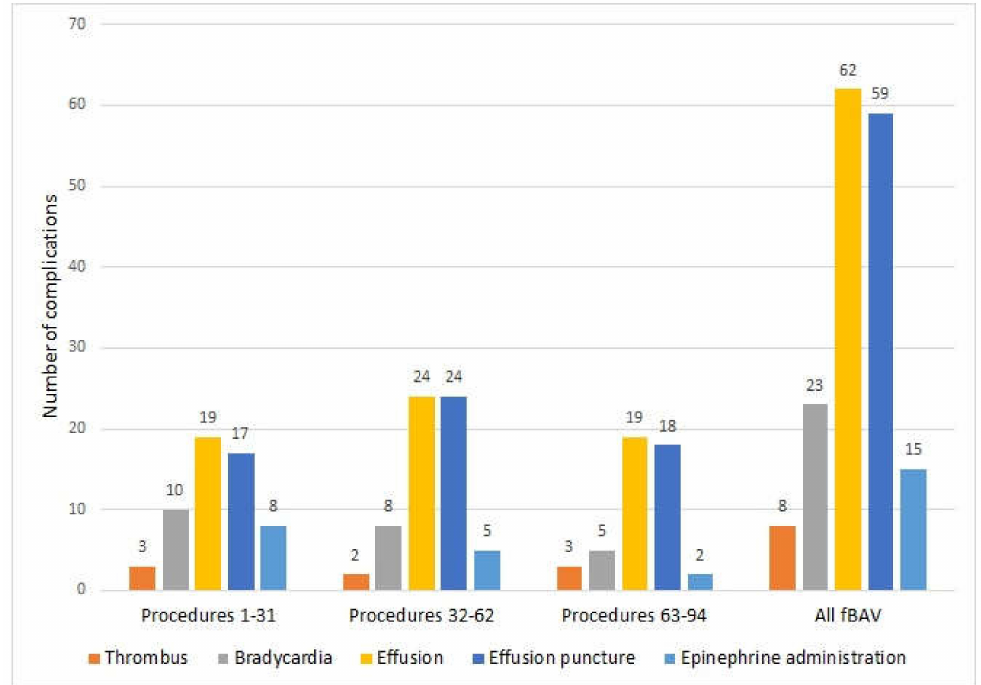
Figure 6. Most common complications during fBAV. Procedures were divided into three parts, with around 30 fBAV in each. From the 32nd procedure, we started to add heparin into the flushing solution and atropine into the umbilical vein. From the 36th procedure, we started to evacuate even a small amount of pericardial e ff